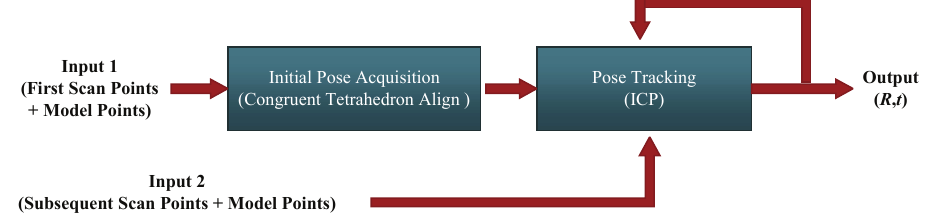
Figure 1. Logical scheme of the proposed method for relative pose